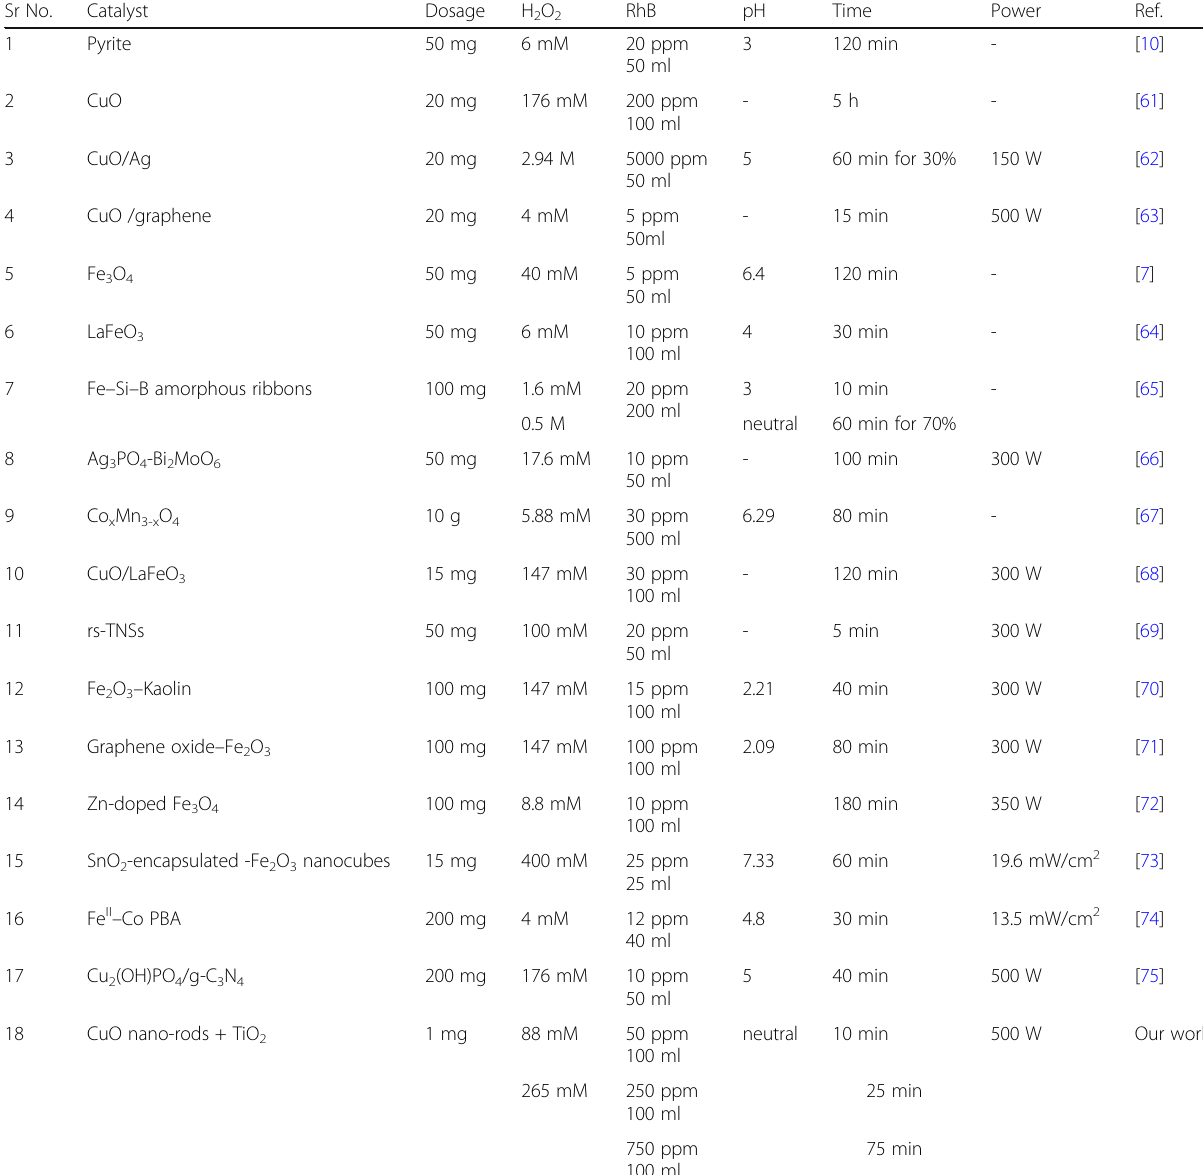
Table 1 Comparison table of different catalysts from earlier researches with our work for dye degradation Sr No.